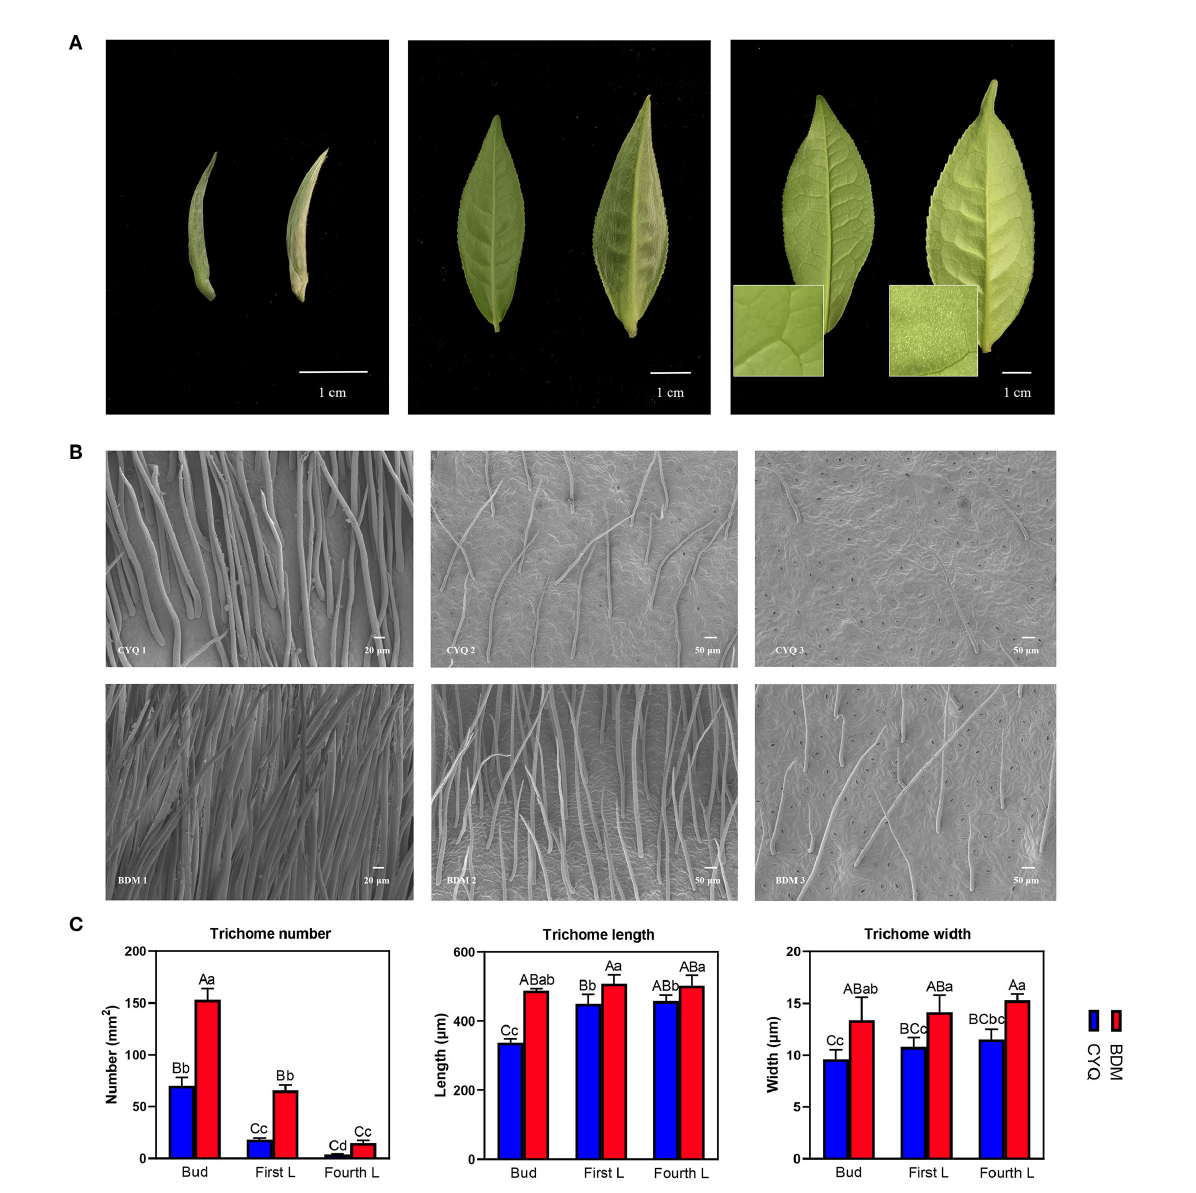
FIGURE1 Morphological analyses of trichomes in tea plant cultivars CYQ and BDM. (A) Digital photograph of the apical buds, first leaves, and fourth leaves of CYQ and BDM (Left: CYQ; Right: BDM; Scale bar = 1cm). (B) Scanning electron microscopy analysis of trichomes on the apical buds, first leaves, and fourth leaves (left to right) of CYQ (top) and BDM (bottom) (Apical buds: scale bar = 20 µ m; first leaves and fourth leaves: scale bar = 50 µ m). (C) Quantitative analysis of the density, length, and width of trichomes on the apical buds, first leaves, and fourth leaves of CYQ and BDM. The experimental data were herein presented as mean ± standard (SD) deviation for the three or more independent biological replicates. The significant differences among various groups were indicated as uppercase letters ( p < 0.01) and lowercase letters ( p <